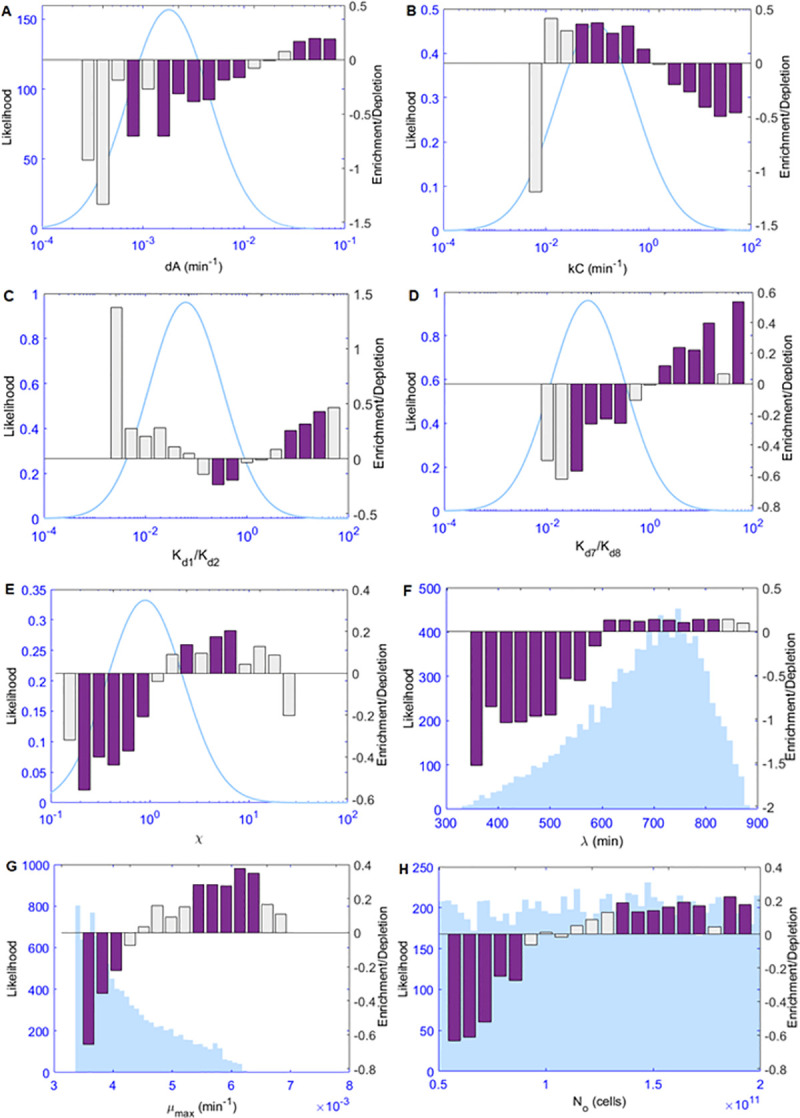
Comparison between the expected parameter values according to the defined priors and the actual parameters of models that had a TLL > −140.The bar plots represent the log-ratio of the actual parameter values over the expected ones in each bin, and the light blue lines in the background shows the original distribution of the sampled values. Purple bar plots correspond to statistically significant differences between the expected and the actual parameter values (two-tailed binomial test p-value < 0.05 corrected for multiple testing according to the number of bins), and the grey bar plots represent statistically insignificant deviations. The parameters with the most pronounced differences were the degradation rate of ScbA (6A), the synthesis rate of GBLs (6B), the ratio of Kd1 (dissociation constant of binding of ScbR to OR) over Kd2 (dissociation constant of binding of ScbR to OA) (6C), the ratio of Kd7 (dissociation constant of binding of ScbR to ScbR-OR) over Kd8 (dissociation constant of binding of ScbR to ScbR-OA) (6D) and the heterogeneity factor χ. With regards to the cellular growth, the most significant differences were observed in the lag phase λ (6F), the maximum growth rate μmax (6G) and the initial number of cells No (6H).